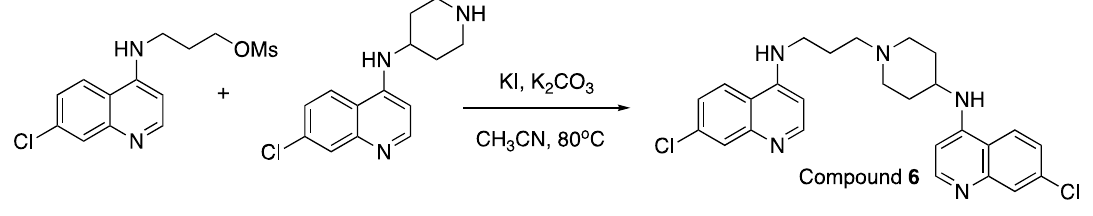
Figure 12. Synthesis of Compound 6 .